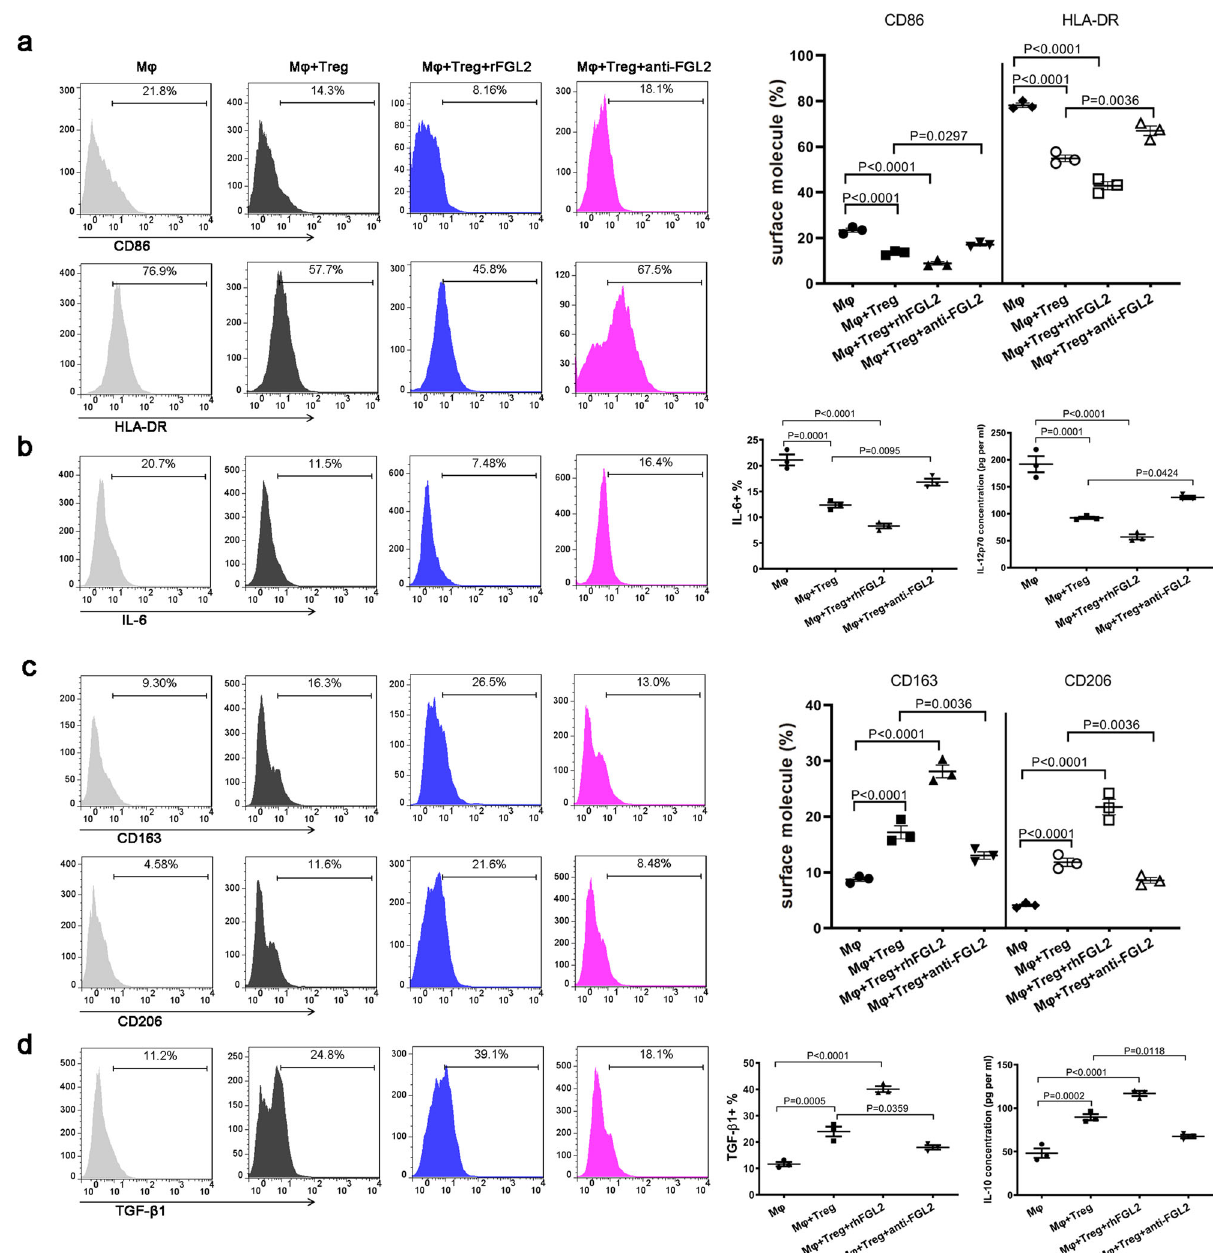
Fig. 5 Tregs promoted pro-repair macrophages polarization via secreting sFGL2. Macrophages (M Ф ) were indirectly co-cultured with Tregs by transwell, recombinant human FGL2 (rhFGL2), or anti-FGL2 antibody were added separately. The expression of CD86, HLA-DR, CD163, CD206, IL-6, TGF- β 1 were analyzed by FCM ( a – d ). The production of IL-12p70 and IL-10 were detected by ELISA ( b , d ). Data represent the mean value ± SEM of three individual experiments ( n =